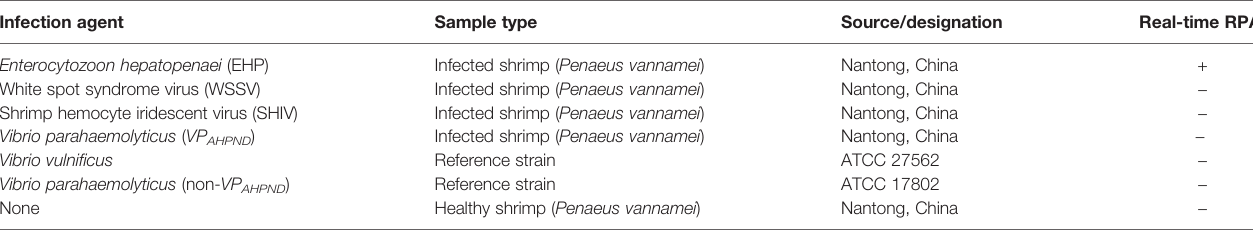
TABLE 2 | Information of shrimp samples and bacteria strains used in this study. Infection